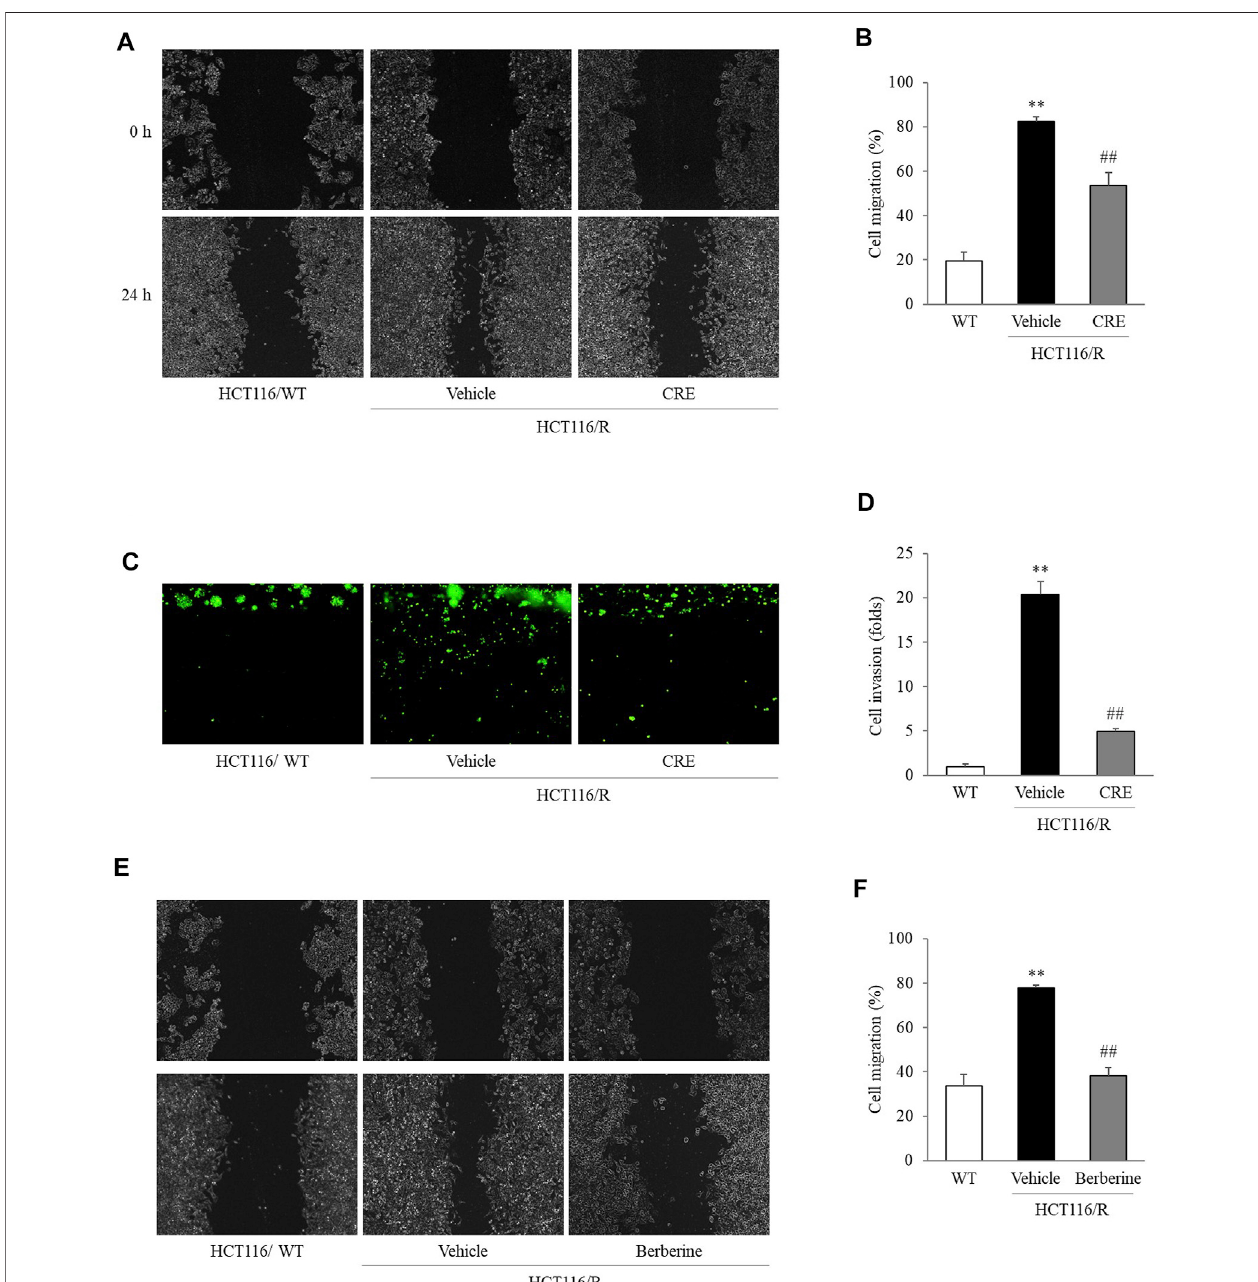
FIGURE 3 | CRE and berberine inhibited the metastatic behaviors of HCT116/R cells. Cell migration was evaluated in a wound-healing assay, and the degree of migration was calculated based on measuring the wound size (A,B,E,F) . Cell invasion was assessed by a 3D invasion assay (C,D) . All the morphological fi ndings were imagedbyan IX71 microscope. The dataareexpressed asthe mean± SDvalue ( n =3). ** p < 0.01, compared to HCT116/WT cells. ## p < 0.01comparedtoHCT116/R cells.